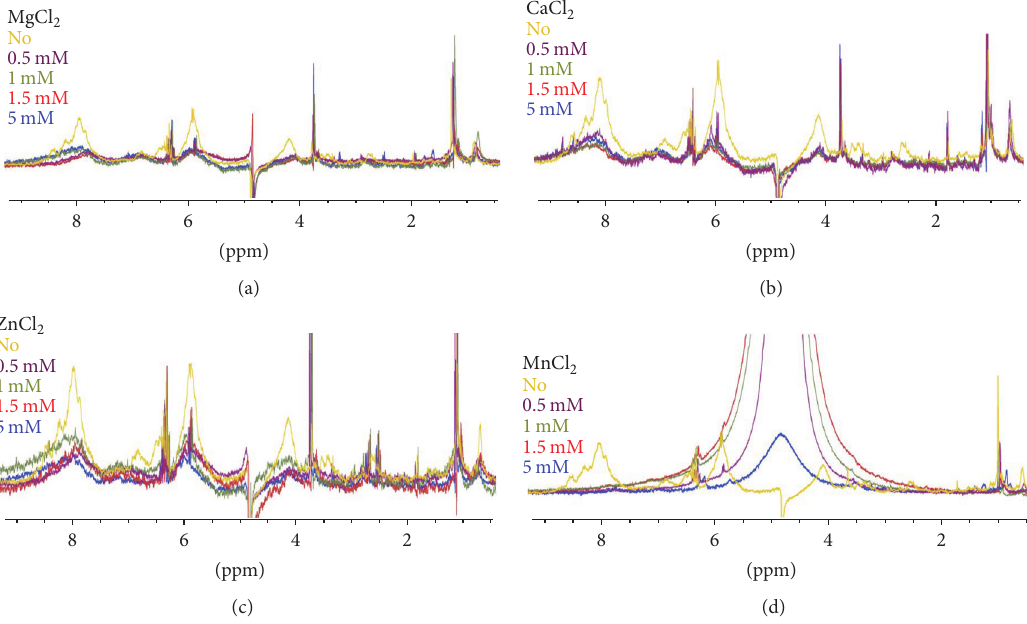
Figure 2: Regions of 1 H NMR titration (500MHz) for RNA with increasing amount of (a) MgCl 2 , (b) b1 Cl 2 , (c) ZnCl 2 , and (d) MnCl 2 from 0 to 5 mM. RNA concentration was 1mg/mL. NMR-spectra were recorded at 298 K, pH